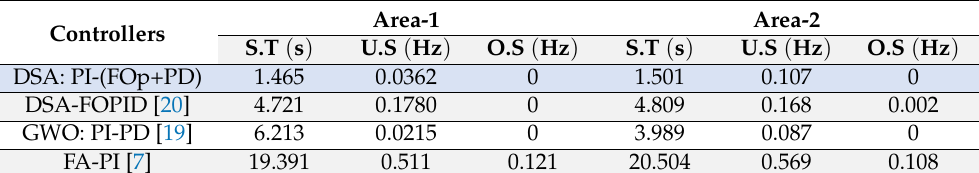
Figure 16. Area-1 response with communication delay.